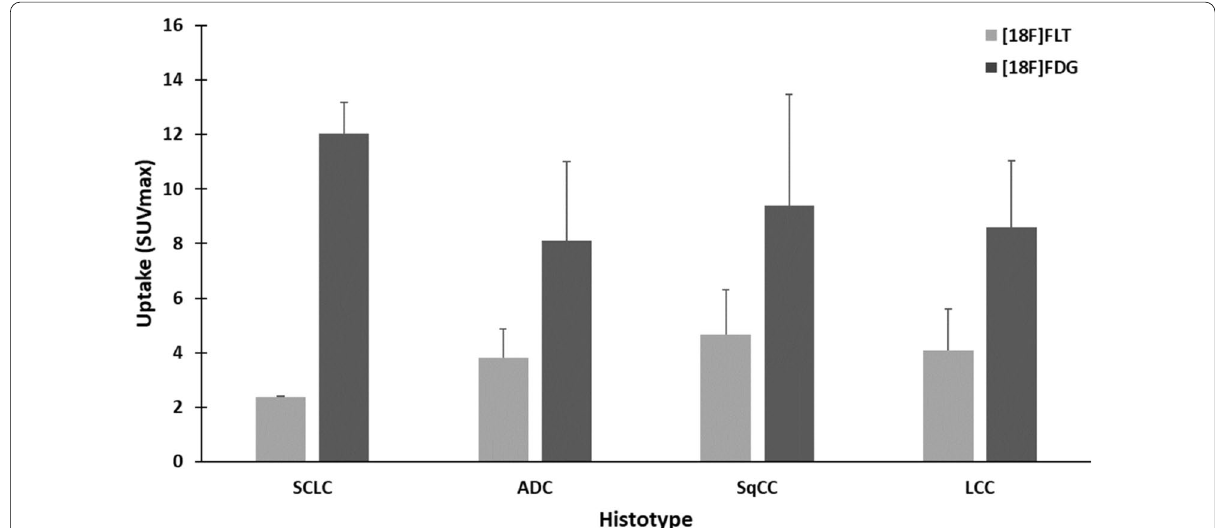
Fig. 3 Histological association of [ 18 F]FLT SUVmax and [ 18 F]FDG SUVmax in different histotypes of